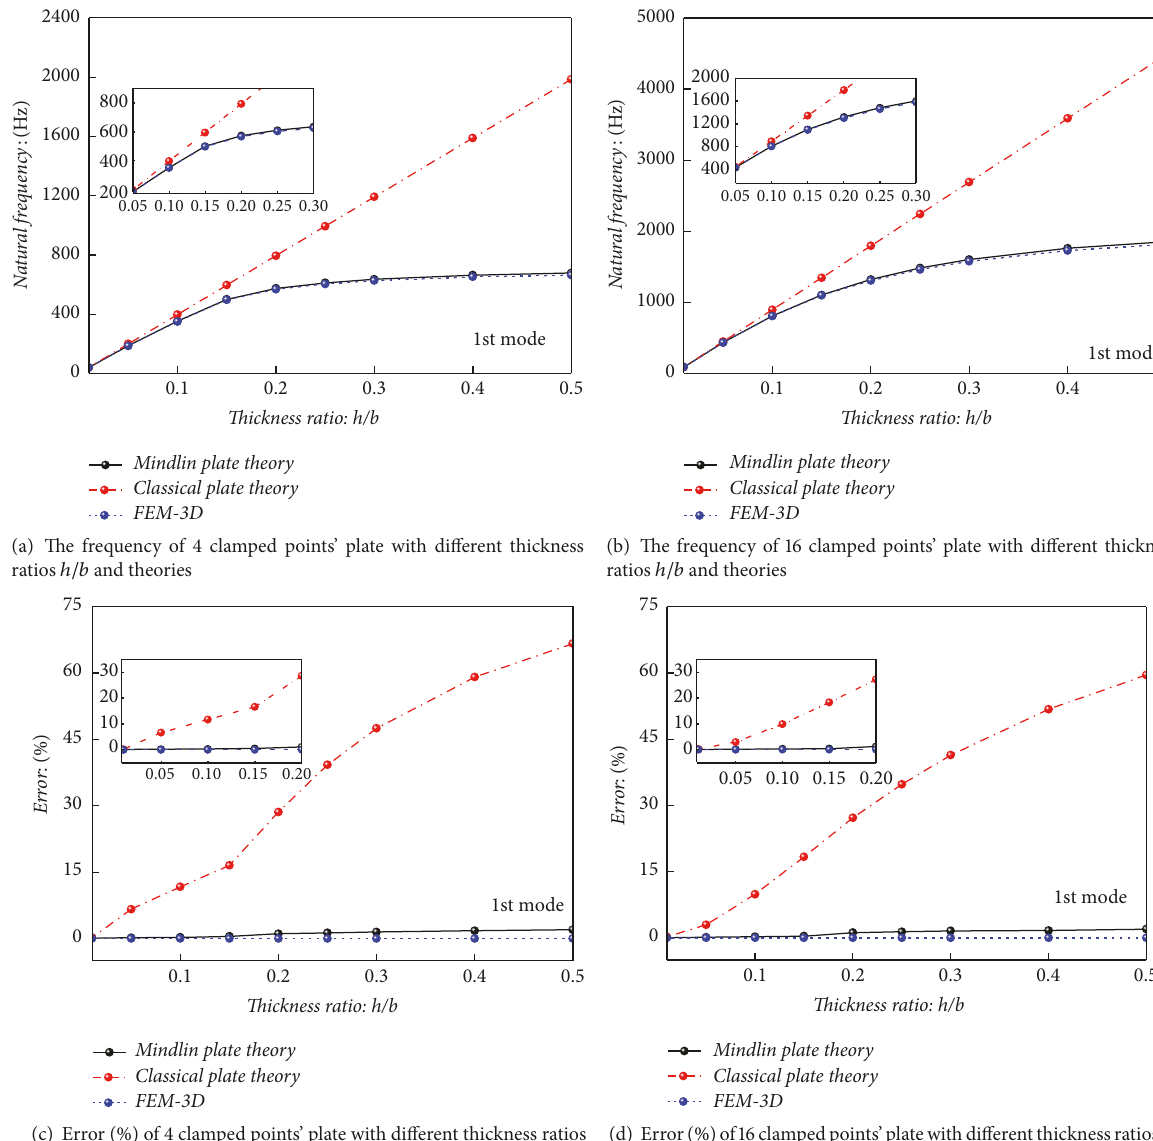
Figure 12: The frequency and error (%) of multipoint-supported plates with different thickness ratios h/b and theories.